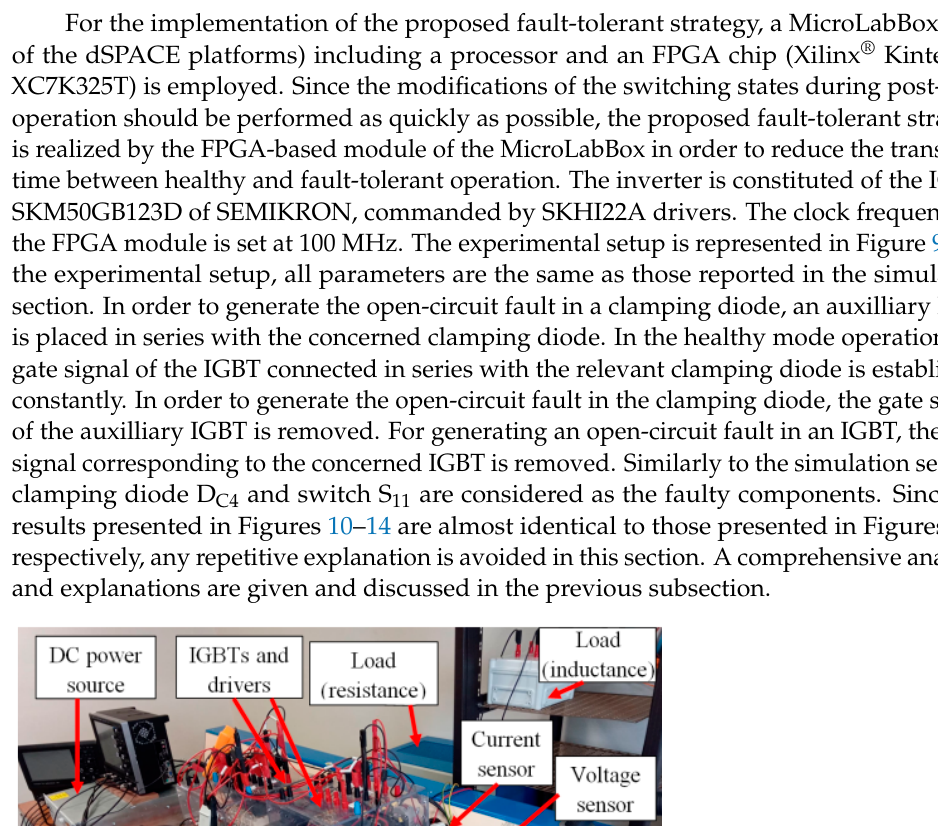
Figure 10. Experimental results of the inverter operation under fault event in D c4 without fault-tol- erant control.